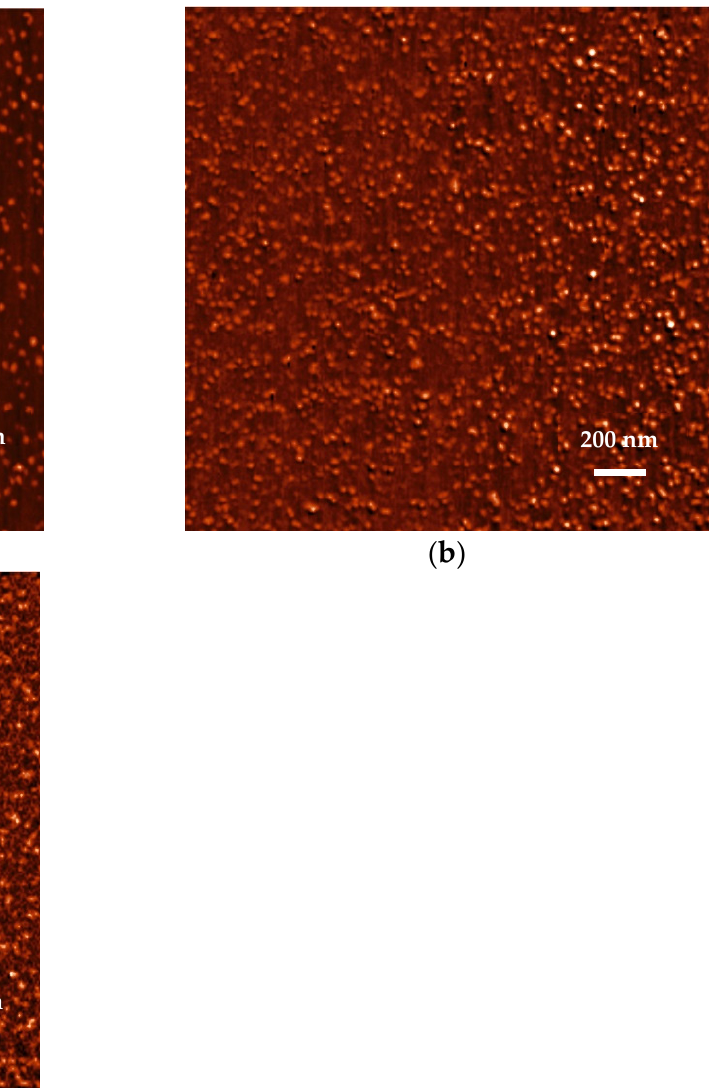
Figure 6. Histogram of the S1R protein size at mica determined by AFM; pH 5.6, c b = 2 mg L − 1 , 150 mM NaCl, adsorption time 15 min. Average aggregate size 14 ± 4 nm. Thus, from the AFM measurements it becomes evident that the average particle size significantly exceeds the S1R monomer size predicted to be 3.84–3.88 nm. This indicates that the protein molecules were aggregated to a considerable degree. The geometrical size of various aggregates schematically shown in Table 2 can be predicted considering the